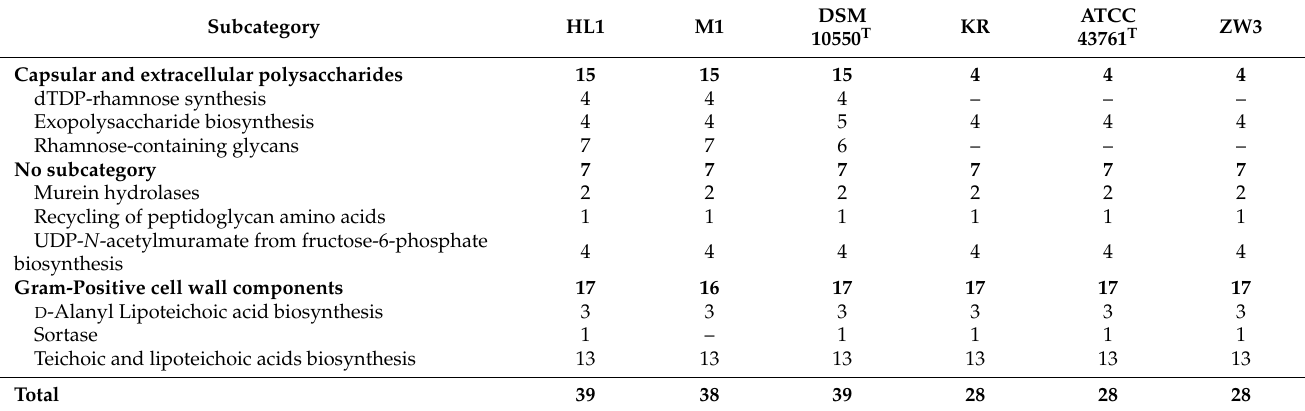
Table 4. Comparison of genes related to the “Cell Wall and Capsule” SEED Category of L. kefiranofa- ciens